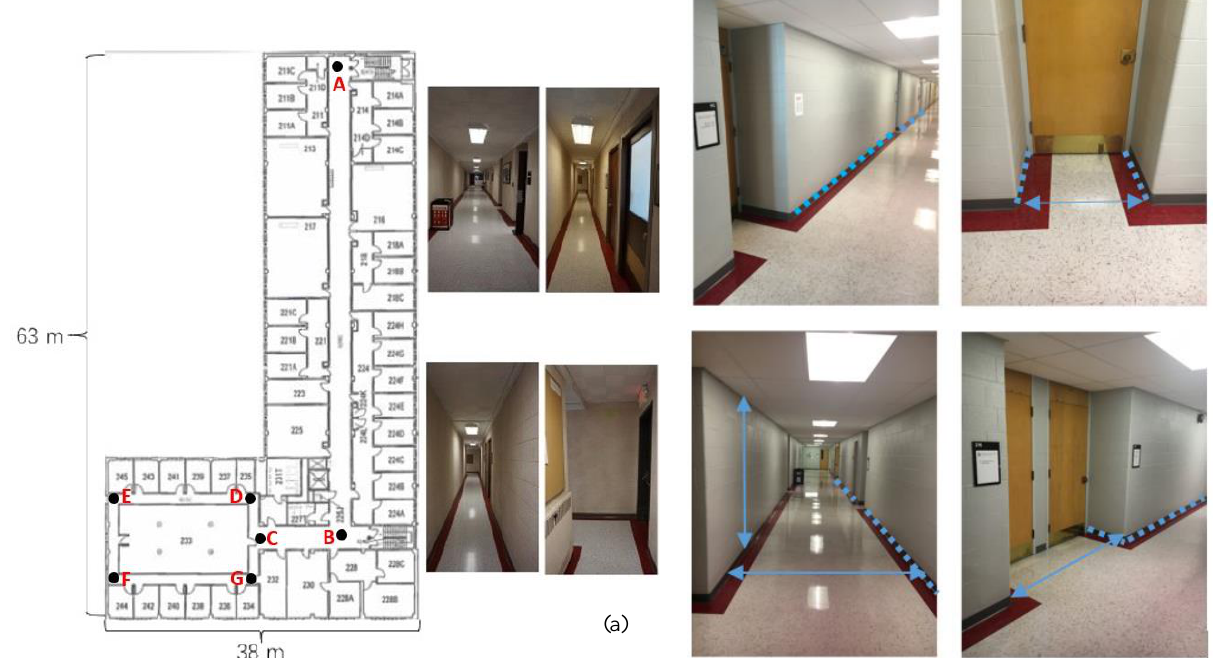
Figure 3. Layout for test corridor and image samples for these corridors (a) (Yuan, 2021), Key features selected for localization performance (arrows indicate corridor width and height and width of door entrances, dashed lines indicate depth of the door entrances and distances between door edges.) (b)